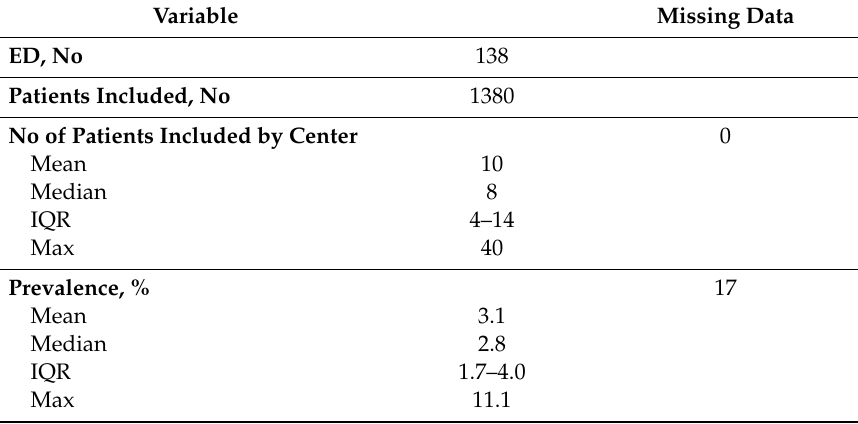
Table 1. Number of inclusions and prevalence of cancer patients in the participating 138 French emergency departments.